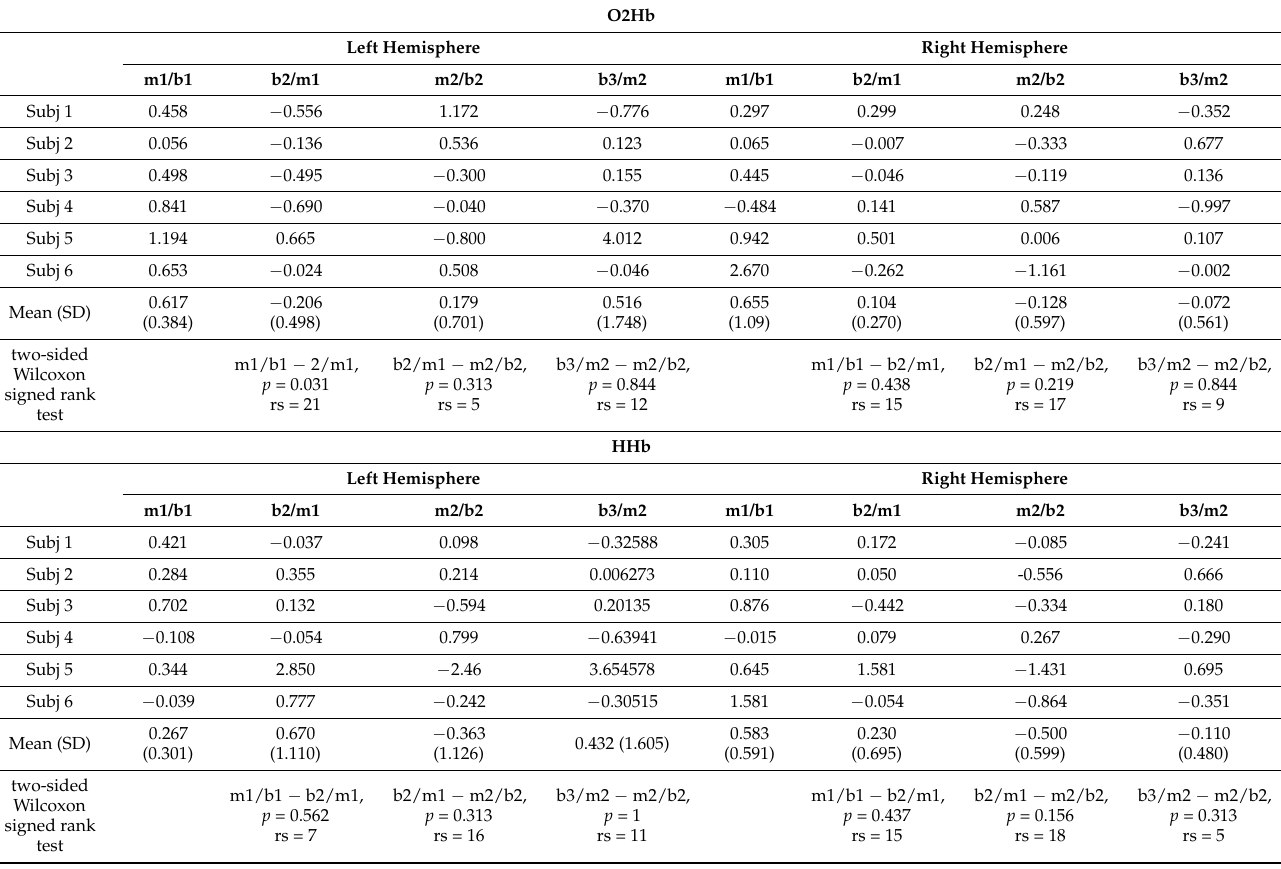
Table 1. LFO.Ratio between subsequent pairs of experimental blocks, for O2Hb (top) and HHb (bottom), for the left hemisphere (left column) and the right hemisphere (right column), for each of the six subjects. Pairwise comparison between LFO.Ratio obtained in the subsequent couples of experimental blocks was performed with Wilcoxon signed rank test; p values are reported between each couple of columns. (m1/b1) from baseline to the first music block; (b2/m1) from the first music block to the second baseline (m2/b2) from the second baseline to the second music block; (b3/m2) from the second music block to the third baseline. Rs = rank statistic. O2Hb Left Hemisphere Right Hemisphere